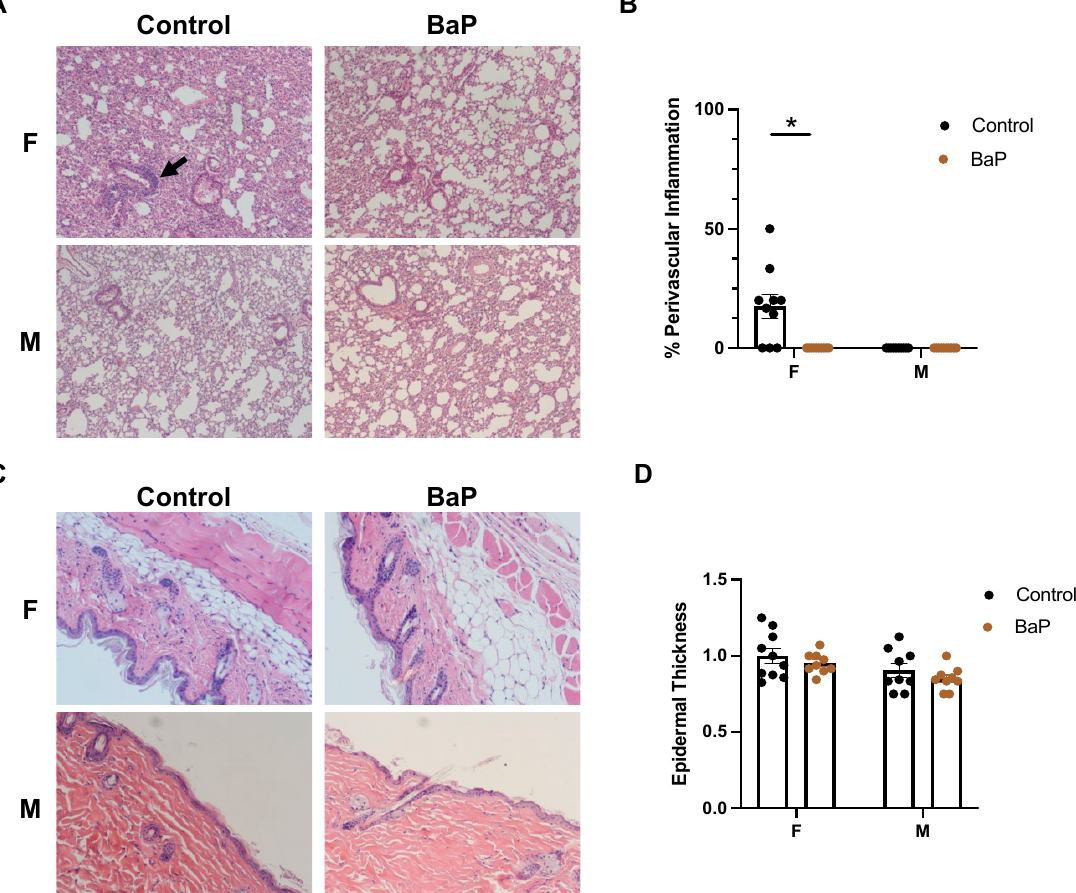
Figure 2. BaP exposure reduced perivascular inflammation in the lung of female MRL mice. ( A ) H&E staining of female (F) or male (M) MRL lung upon vehicle (control) or BaP (BaP) treatment, with the arrow pointing to the site of perivascular inflammation (4×). ( B ) Quantification of perivascular inflammation of bronchioles in female (F) or male (M) vehicle (control) or BaP (BaP)-treated lungs. *, p < 0.05, Student’s t -test. ( C ) H&E staining of female (F) or male (M) MRL skin upon vehicle (control) or BaP (BaP) treatment (4×). ( D ) Quantification of epidermal thickness in female (F) or male (M) vehicle (control) or BaP (BaP)-treated skin.